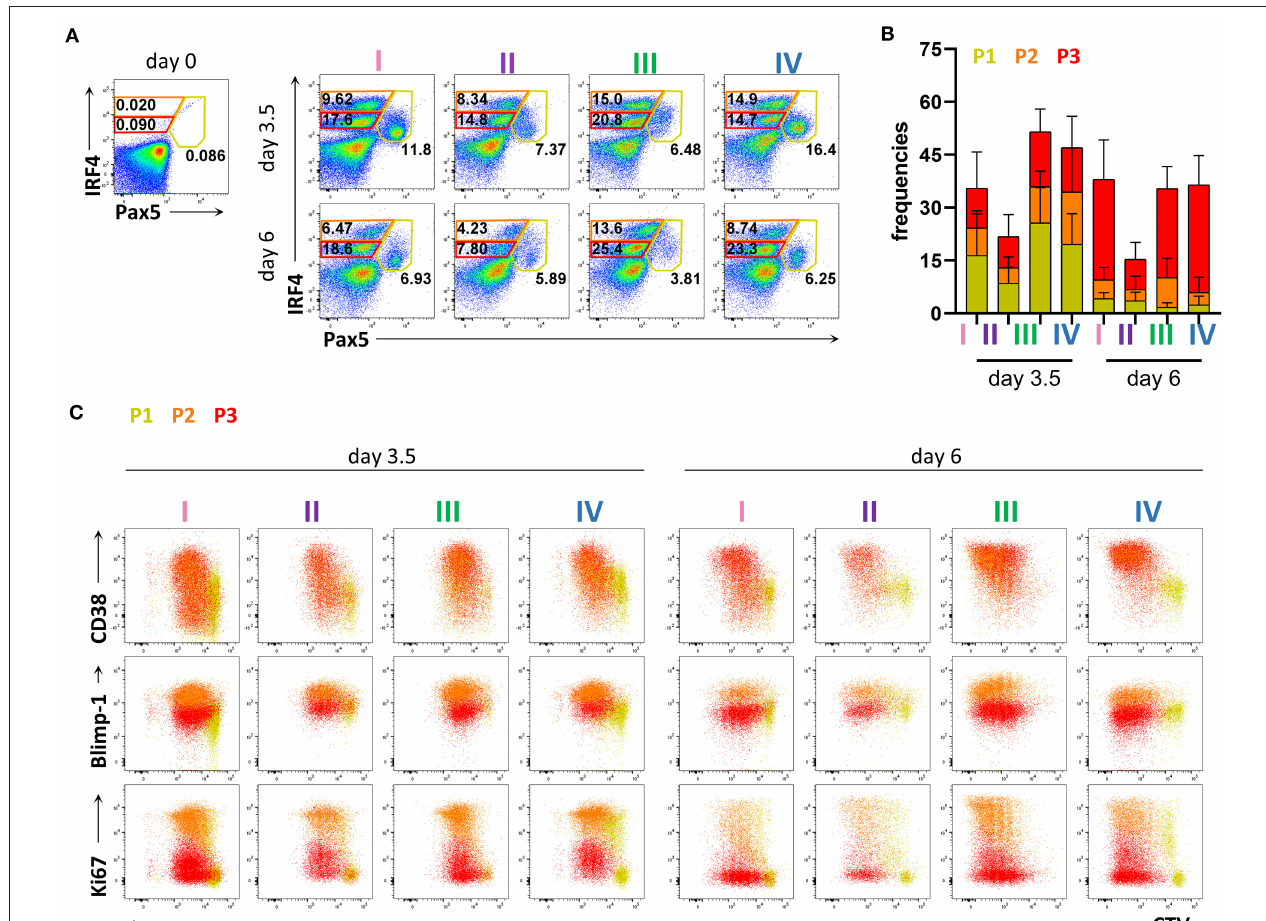
FIGURE 2 | Flow cytometric analysis of transcription factor expression in human primary B cells after in vitro differentiation. Total human B cells from healthy donors were stimulated under conditions described in Figure 1A and analyzed by flow cytometry at days 3.5 and 6. Cells were pre-gated on FSC-A/FSC-W to identify singlets and on FSC-A/SSC-A to identify lymphocytes. (A) Representative plots showing gating strategy for IRF4 lo Pax5 hi (P1), IRF4 hi Pax5 lo (P2), and IRF4 int Pax5 lo (P3) populations. Numbers in or adjacent to gates indicate cell frequencies. (B) Frequencies of IRF4 low Pax5 hi (P1), IRF4 hi Pax5 lo (P2), and IRF4 int Pax5 lo (P3) cells. Bars and error bars indicate mean ± s.d. Data are pooled from three independent repeats with 5 donors per experiment. (C) Representative plot overlays showing CD38, Blimp-1 and Ki67 expression for the IRF4 low Pax5 hi (P1), IRF4 hi Pax5 lo (P2), and IRF4 int Pax5 lo (P3)